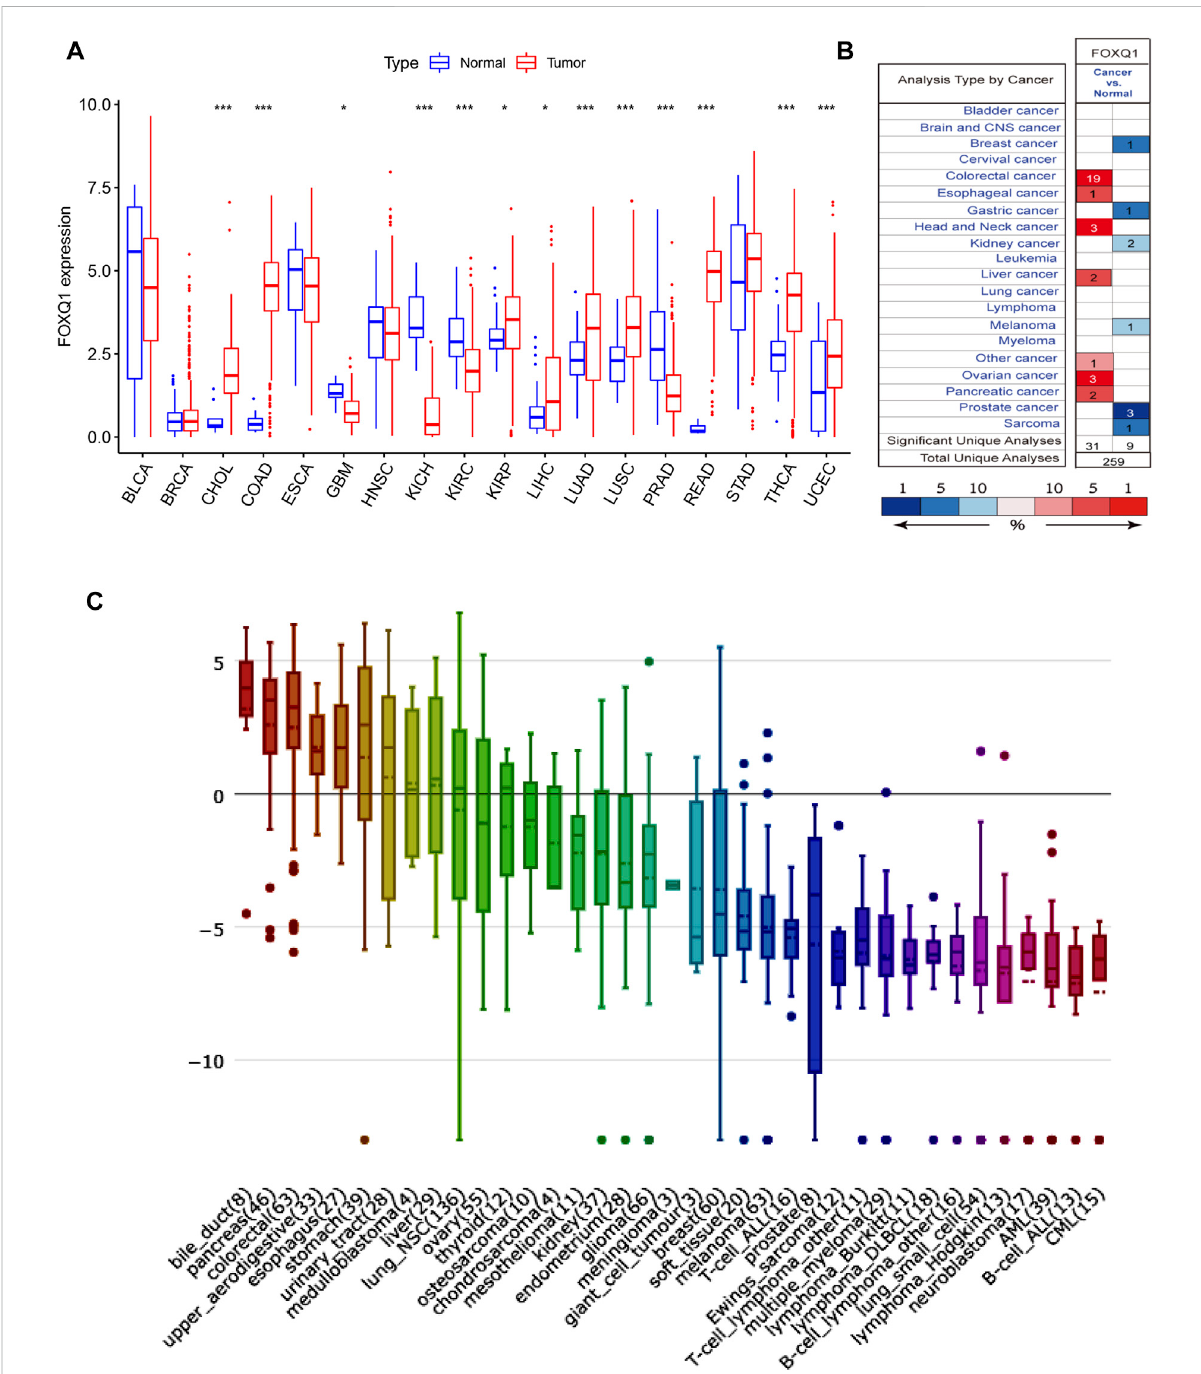
FIGURE 1 FOXQ1expressionpro fi lesattissueandcelllevelsinpan-cancer. (A) Theexpressionpro fi leofFOXQ1attissuelevelinTCGAdatabase.Redcolor represents tumor samples and blue color represents normal samples. (B) The expression pro fi le of FOXQ1 at tissue level in Oncomine database. The number represent the count of datasets in the plot. Redcolor represents high expression and blue color represents low expression. The color depth was related to the sequencing of gene expression differences. Red saturated color represented top 1%. Medium saturated color block represents top 5%; White blocks represent the top 10%, blue and so on. The “ Total Unique Analyses ” means that the total number of datasets for differential analysis. (C) The expression pro fi le of FOXQ1 at cell level in CCLE database. The numbers in brackets represent the sample size of tumor cell lines and the y axis represent the expression level of FOXQ1. Red, green, blue, and violet indicate a relative decrease in expression levels. TCGA, The Cancer Genome Atlas; CCLE, Cancer Cell Line